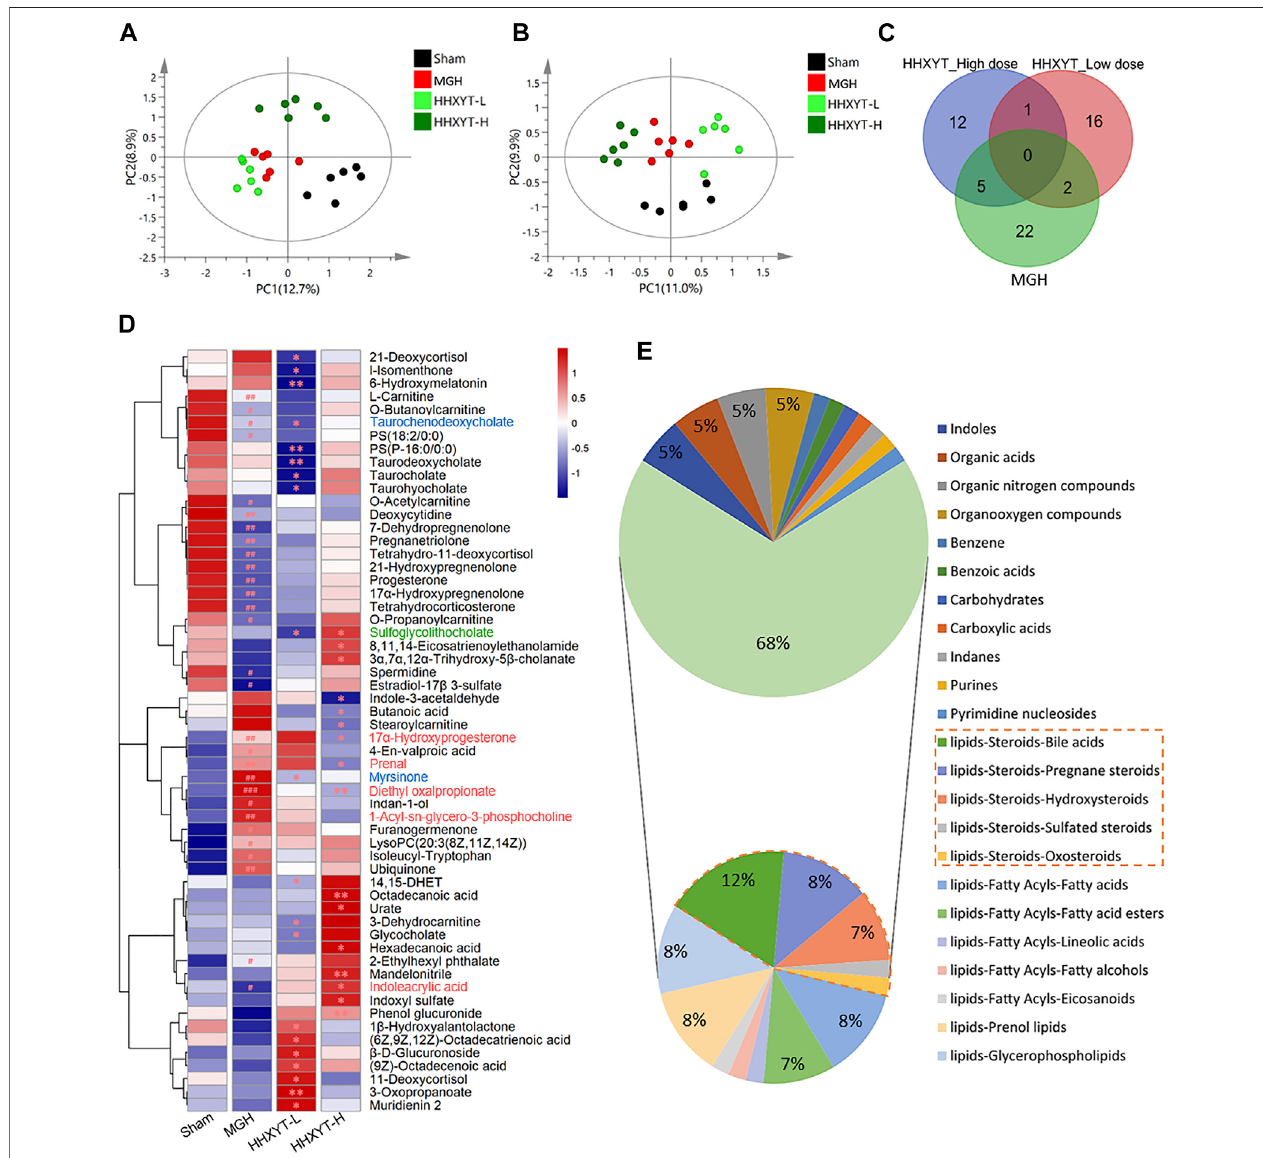
FIGURE5| Endogenous differentialmetabolites wereidenti fi edfrom themetabolomics experiment. PLS-DAscoreplotsofSham, MGHHHXYT-L, and HHXYT-H, in positive mode (A) and negative mode (B) . (C) The intersection of endogenous differential metabolites in the 3 groups. (D) Heatmap of 58 endogenous differential metabolites. n = 6, # p < 0.05, ## p < 0.01, compared to Sham; * p < 0.05, ** p < 0.01, compared to MGH. The red compound name means the common differential metabolites between HHXYT-H and MGH; Blue: the common differential metabolites ofHHXYT-L/MGH; Green: thecommon differential metabolites ofHHXYT-H/ HHXYT-L. (E) Categories of endogenous differential metabolites. 31% of steroids were marked with the orange border.